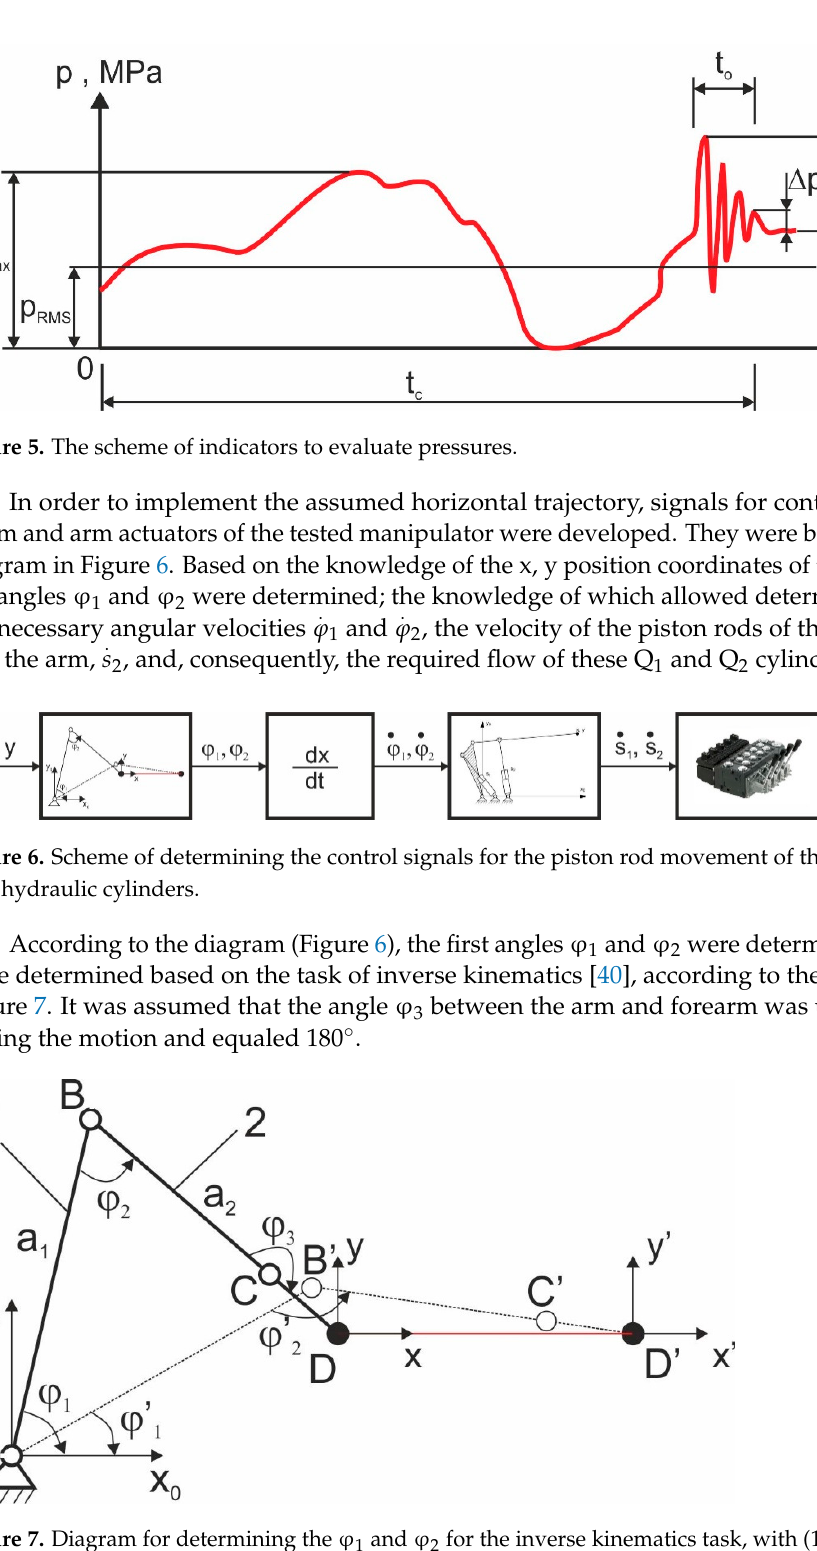
Figure 4. The scheme of indicators to evaluate the trajectories, with (1) trajectory of effector and (2) reference trajectory.